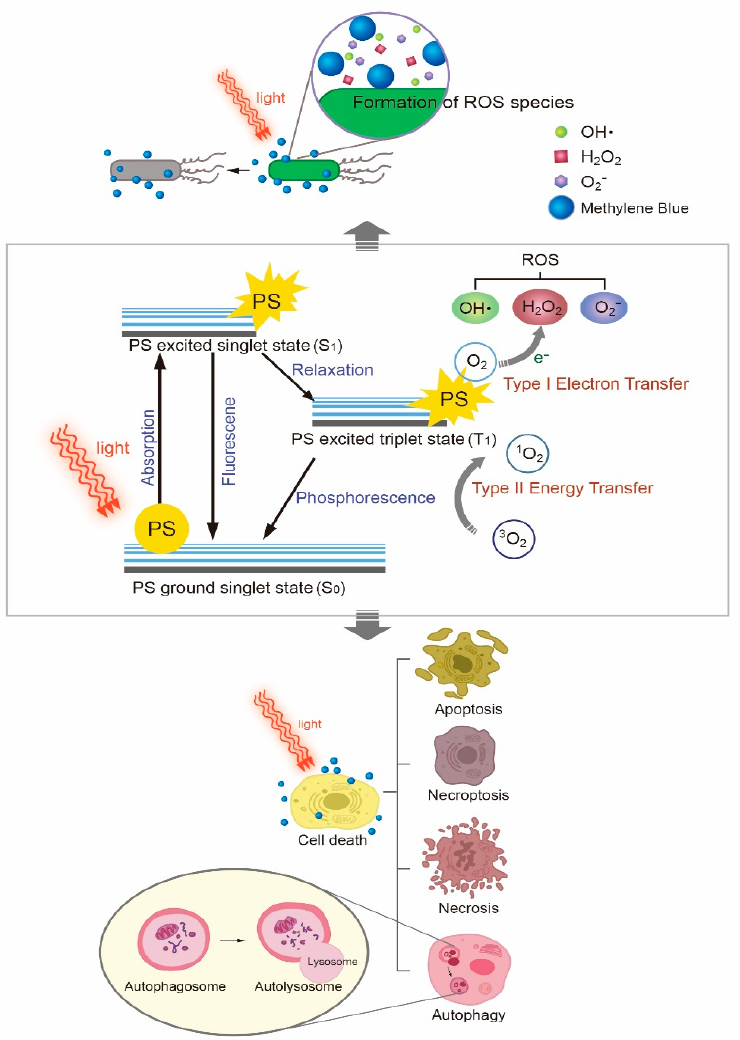
Figure 2. Type I and II reactions in photodynamic therapy and their influences on microbial cellular death and mammalian cell deaths. The types of mammalian cell death include apoptosis, necrosis, necroptosis, and autophagy.